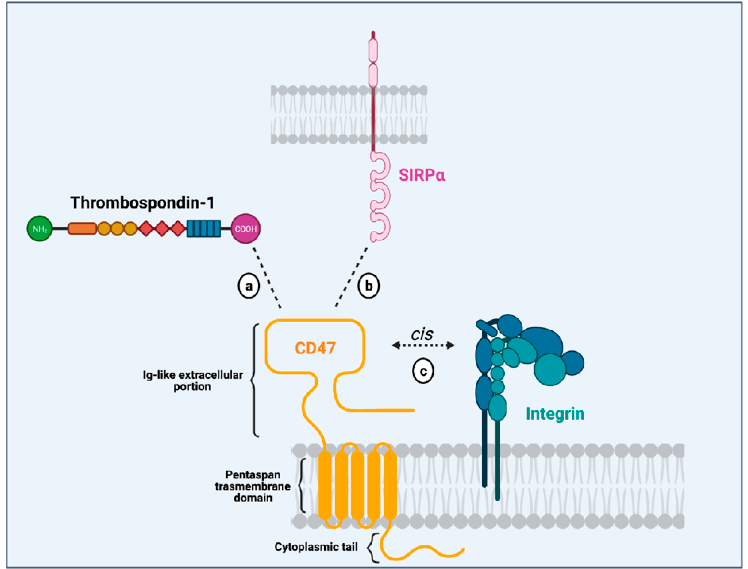
Figure 1. Illustration of the CD47 structure (in yellow) showing its single immunoglobulin (Ig)-like domain that interacts with thrombospondin-1 (TSP-1; ( a ), SIRP α ( b ), and integrins ( c ). It also depicts CD47 multispan transmembrane domain and its intracytoplasmic tail. Created with Biorender.com. Another CD47 ligand is thrombospondin ‐ 1 (TSP ‐ 1). TSP ‐ 1 is a matrix glycoprotein